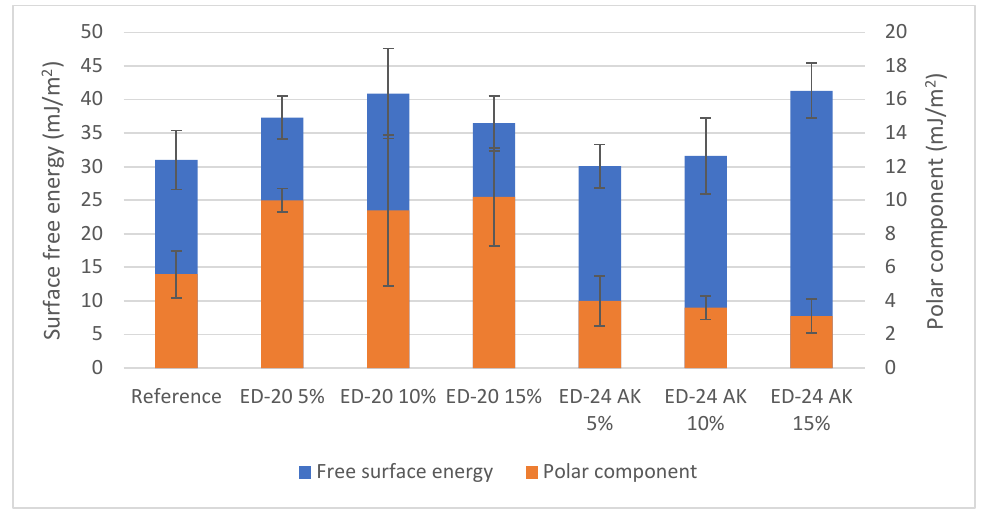
Figure 12. Surface energy and its components of the samples studied.